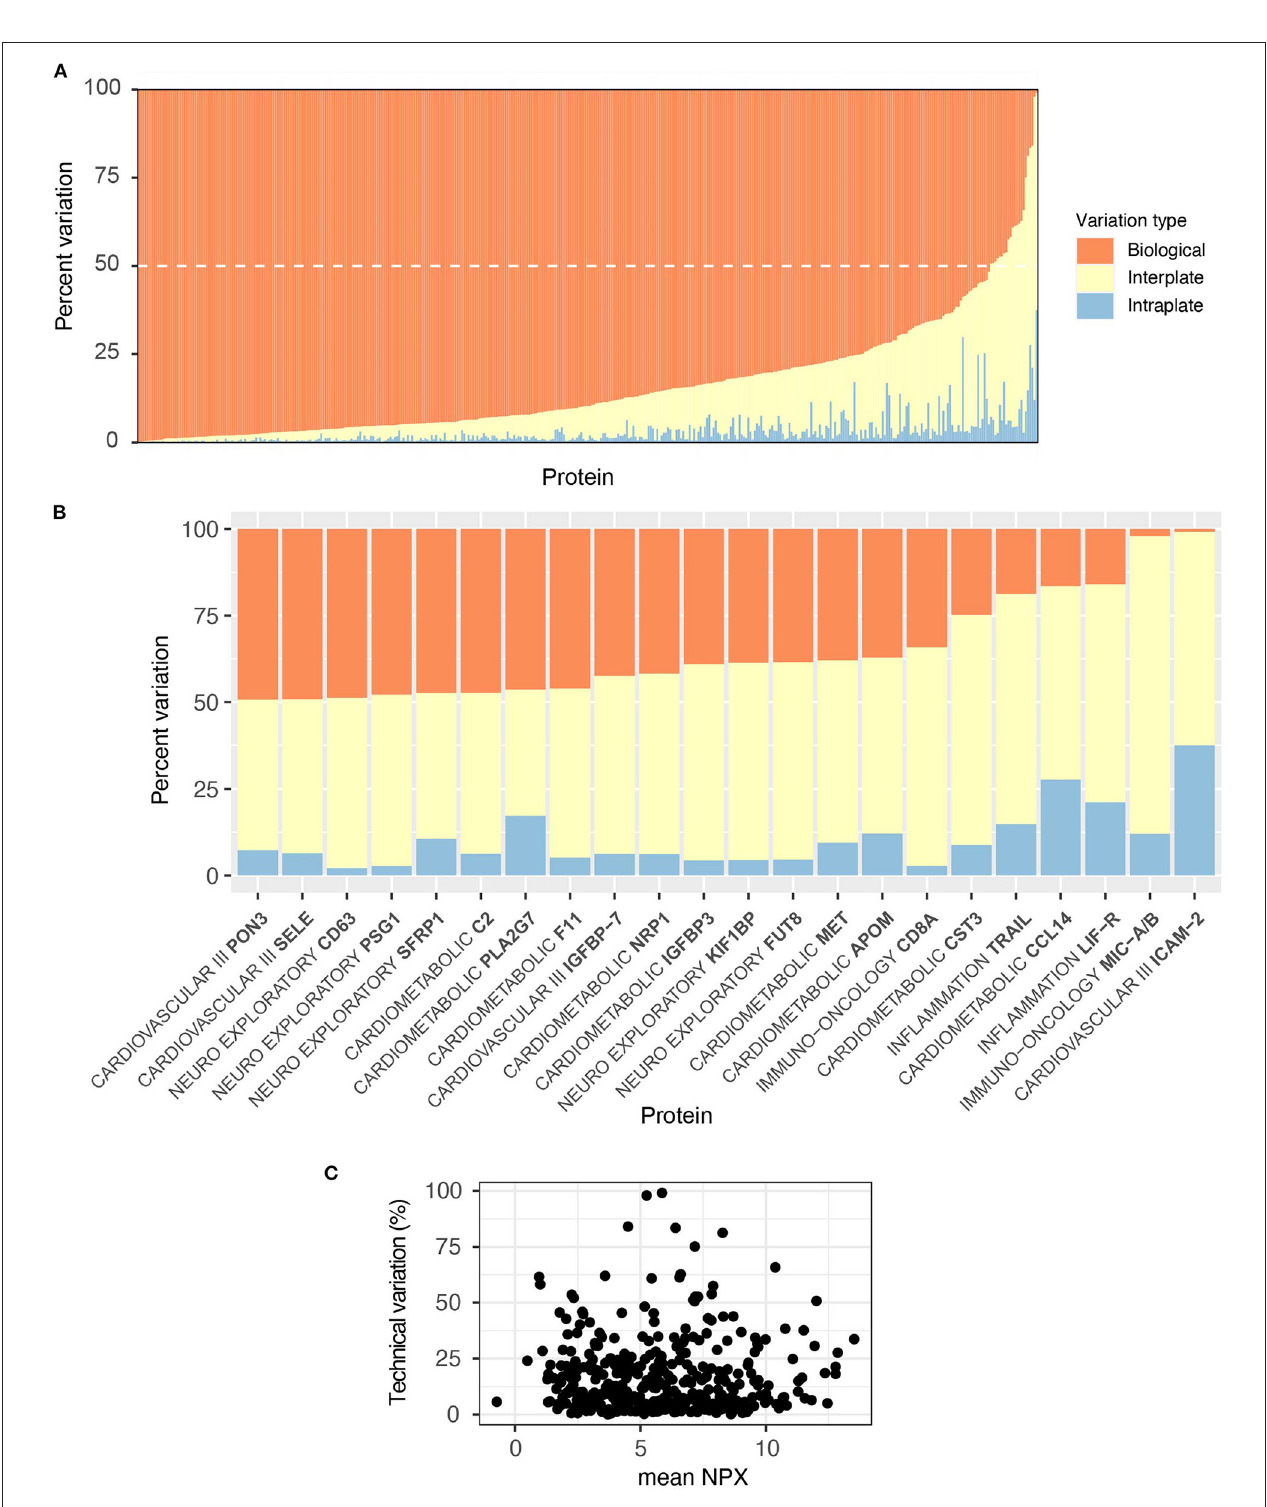
FIGURE 5 | Olink is technically robust; individual differences are the largest source of variability. The proportion of technical (intra- and inter-plate) vs. biological sources of variance per protein was evaluated with an ANOVA on our independently included control samples. Variability arising from each source was expressed as a proportion of the sum of Mean Squares for that protein. (A) For all but 24 proteins, sample variability was primarily due to individual biological differences (orange bars), the dashed white line shows the 50% cut-off. (B) These 24 proteins, listed alongside their corresponding panel, were subject to a higher proportion of technical variability ( > 50%), shown in yellow and blue. (C) There was no relationship between proportion of technical variations (intra- plus inter-) and absolute NPX value.